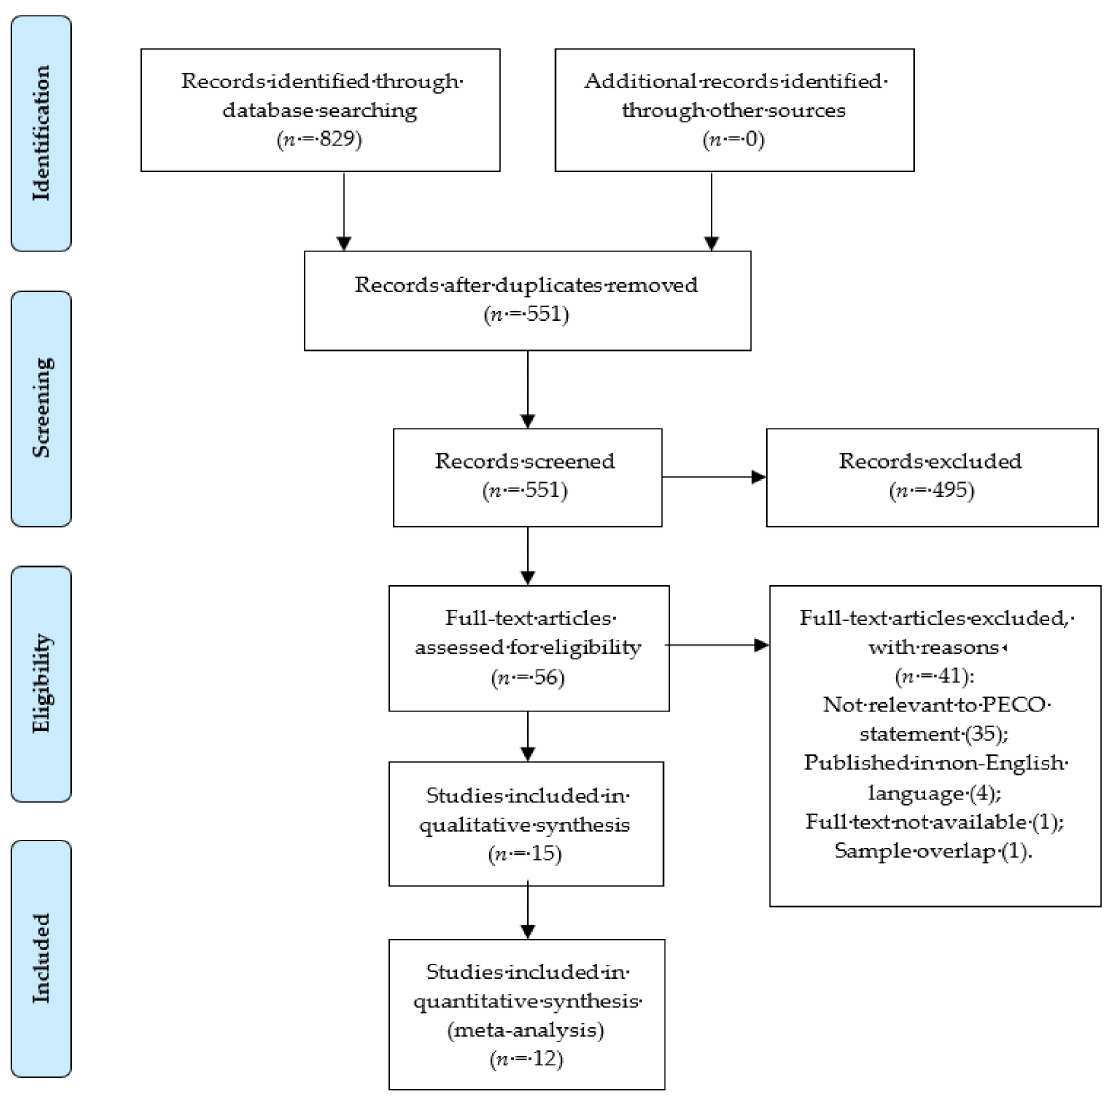
Figure 1. PRISMA study flow diagram describing the process of study selection. Abbreviation: PECO: Population, Exposure, Comparator,